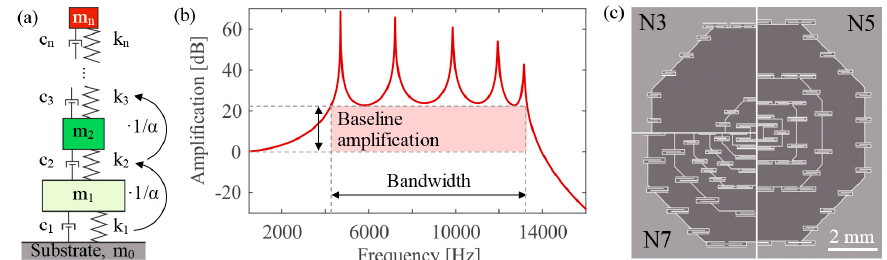
Figure 1. ( a ) Lumped mass-spring model. Resonators with the same Eigenfrequency are coupled in series. Spring stiffnesses and masses (exception: m n ) decrease with a constant factor α ; ( b ) Corresponding transfer function of the last mass in a system with five coupled masses with indicated baseline amplification and bandwidth; ( c ) Overview of the 3 different designs: ¼ N3, ½ N5 and ¼ N7. They have all the same total mass but different factors α (11.7, 3.0 and 1.9 respectively).